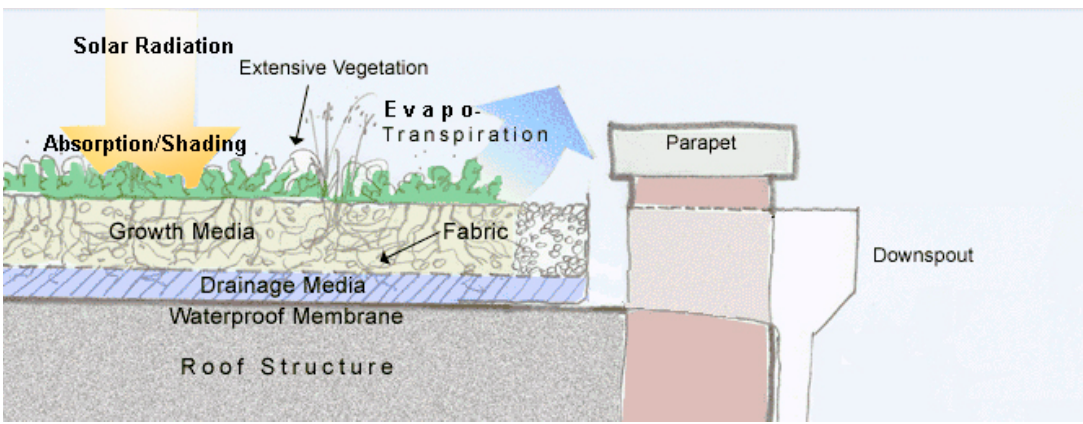
Figure 4. Example of a green roof and its main components (source: [101]).